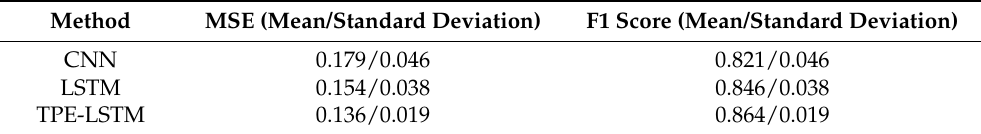
Table 3. The classification performance: the overall results. Cleveland dataset.